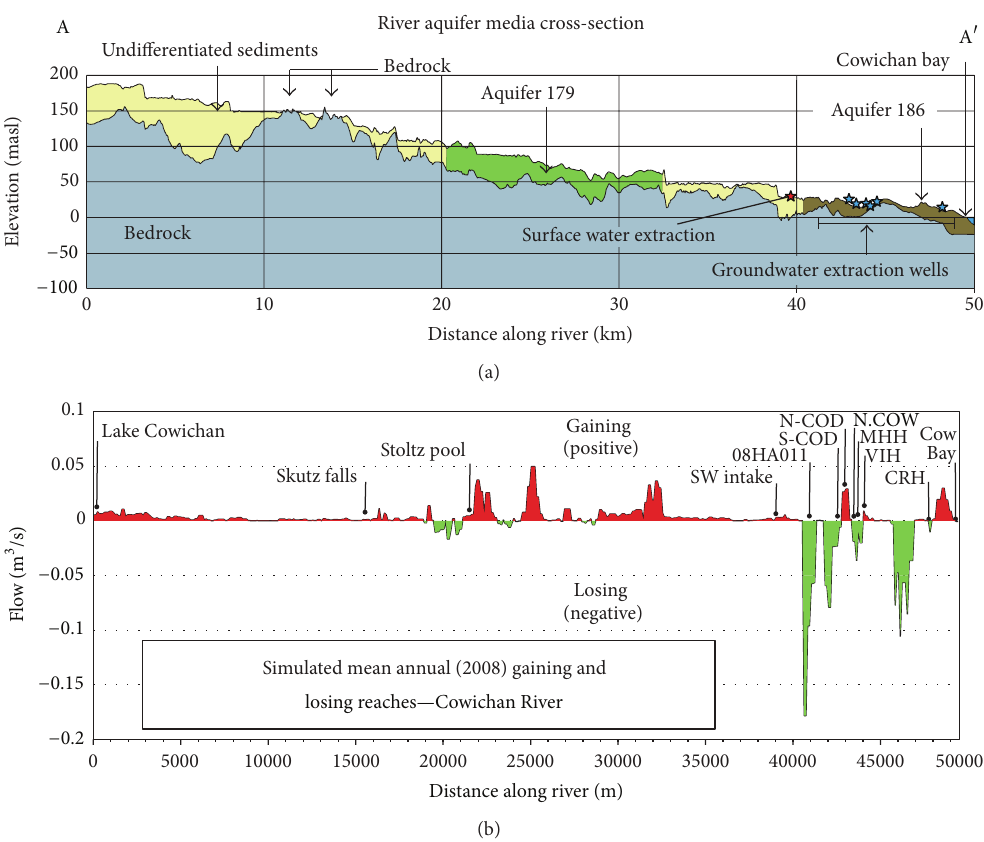
Figure 13: (a): the subsurface geology underlying the Cowichan River. Blue stars show groundwater wells and the red star shows the surface water diversion (pumping wells: S-COD/N-COD—City of Duncan wells, MHH—Marine Harvest Hatchery, N.Cow—North Cowichan well, VIH—Vancouver Island Hatchery, and CRH—Cowichan River Hatchery). (b): simulated annual exchanges between the Cowichan River and the